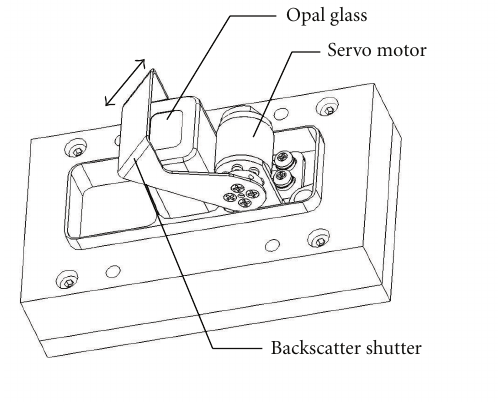
FIGURE 2: LED light source with backscatter